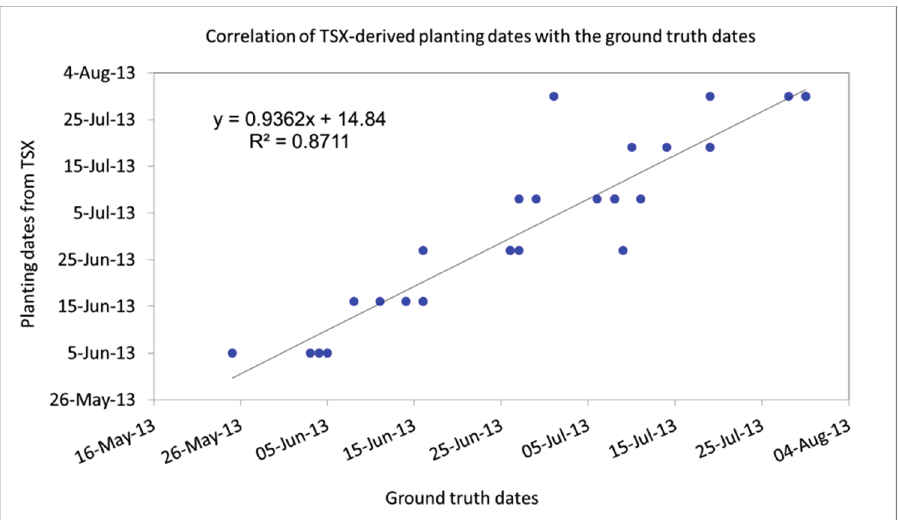
Figure 9. Correlation of TSX-derived planting dates with the ground data.